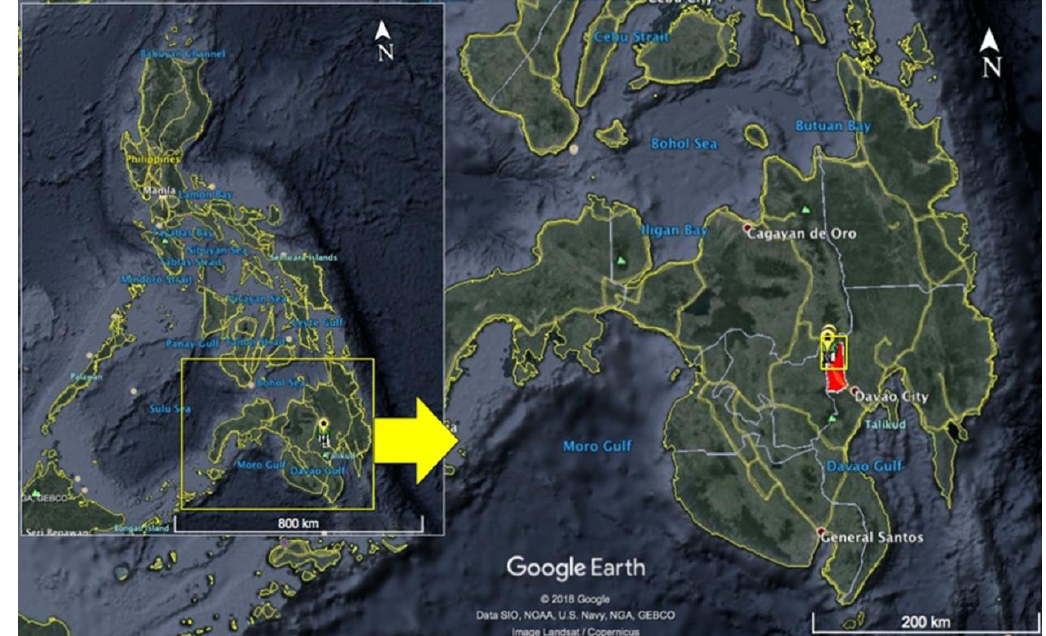
Fig. 1. Location map of the research area in Marilog District, Davao City,